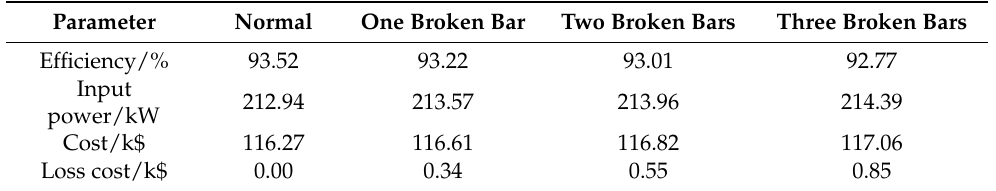
Table 5. Annual operating costs with BRB faults at different degrees.